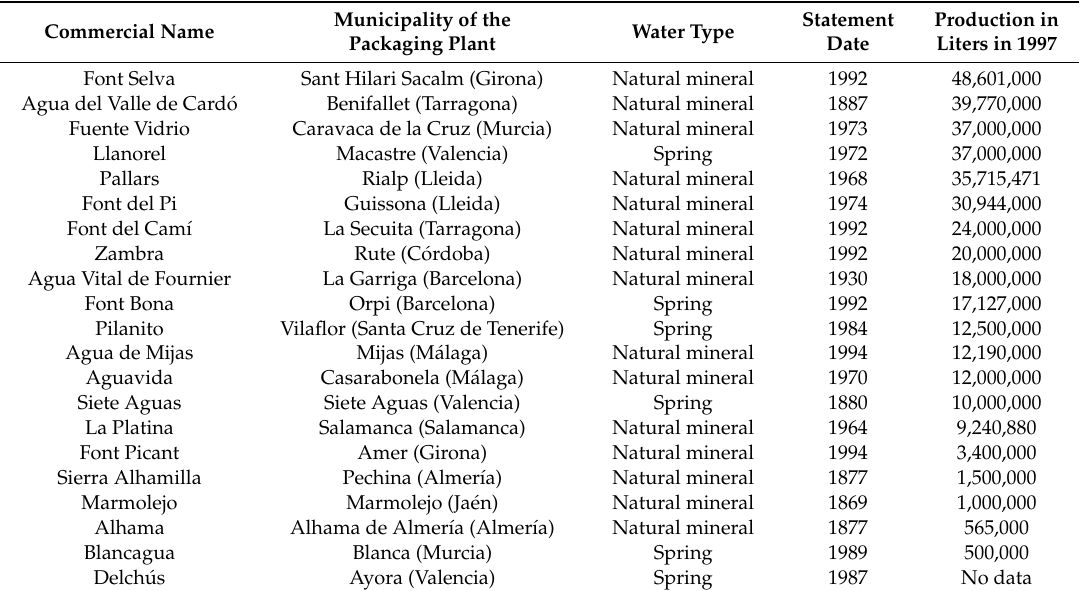
Table 3. Mineral water and spring water * packaging plants that have ceased their activity in Spain between 2001 and 2019. Source: [39] European Commission: List of Mineral Waters Recognised by Member States (consultation on 8 February